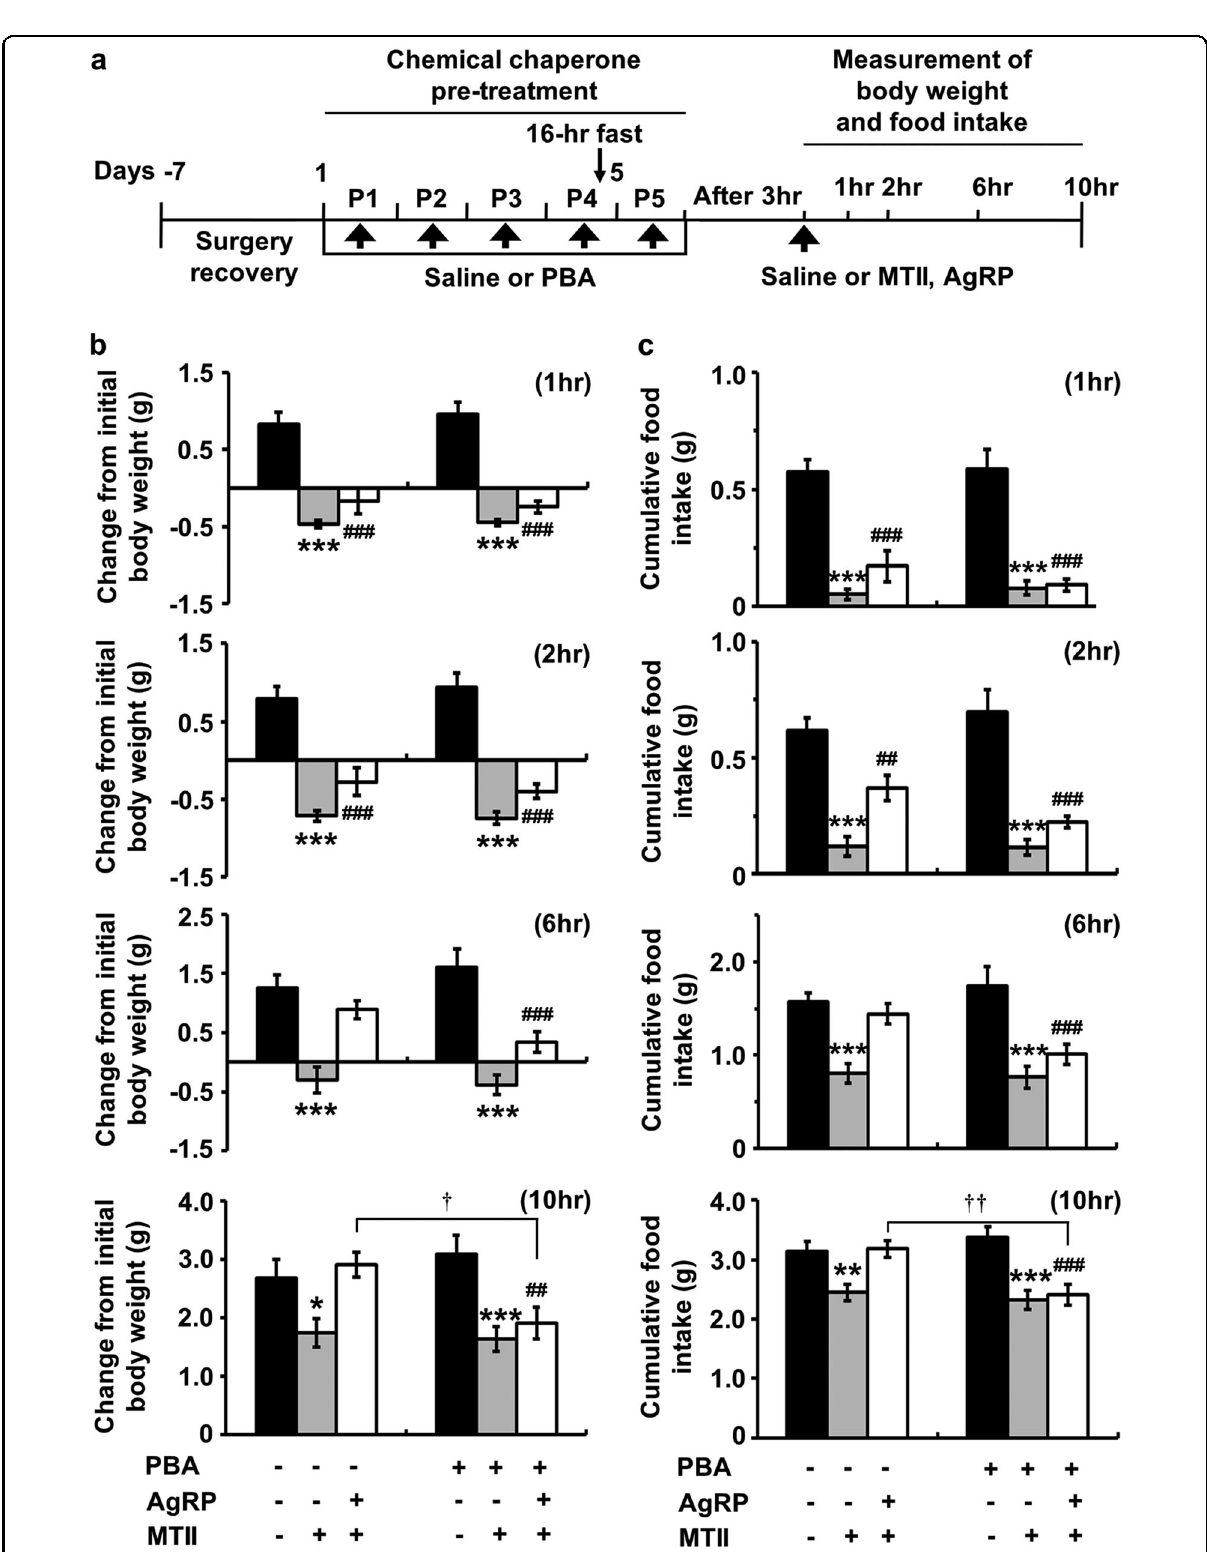
Fig. 6 Effect of the chemical chaperone 4-PBA on the MC4R-mediated regulation of body weight and food intake. a Experimental protocol: 10-week-old male mice were injected with saline or 4-PBA (200mg/kg, ip) for 5 days; on the 5th day, mice fasted for 16 h were treated with AgRP (2 nmol, i.c.v.) or MTII (3 nmol, i.c.v.). At different time points after each injection, the changes in b body weight and c food intake were measured. Two- way ANOVA, Bonferroni post hoc tests for b – c : n = 9 per group, * P < 0.05, ** P < 0.01, *** P < 0.001, vehicle versus MTII; ## P < 0.01, ### P < 0.001, vehicle versus AgRP + MTII; † P < 0.05, †† P < 0.05, non-4-PBA-treated versus 4-PBA-treated group. The data are presented as the mean ±